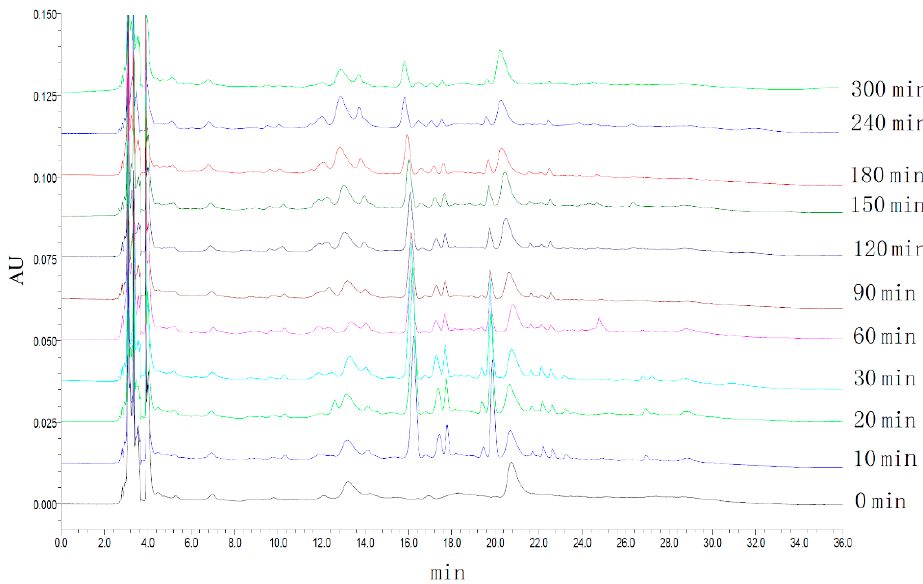
Figure 4. The HPLC fingerprint of rabbit plasma of G-2 decoction at different times.